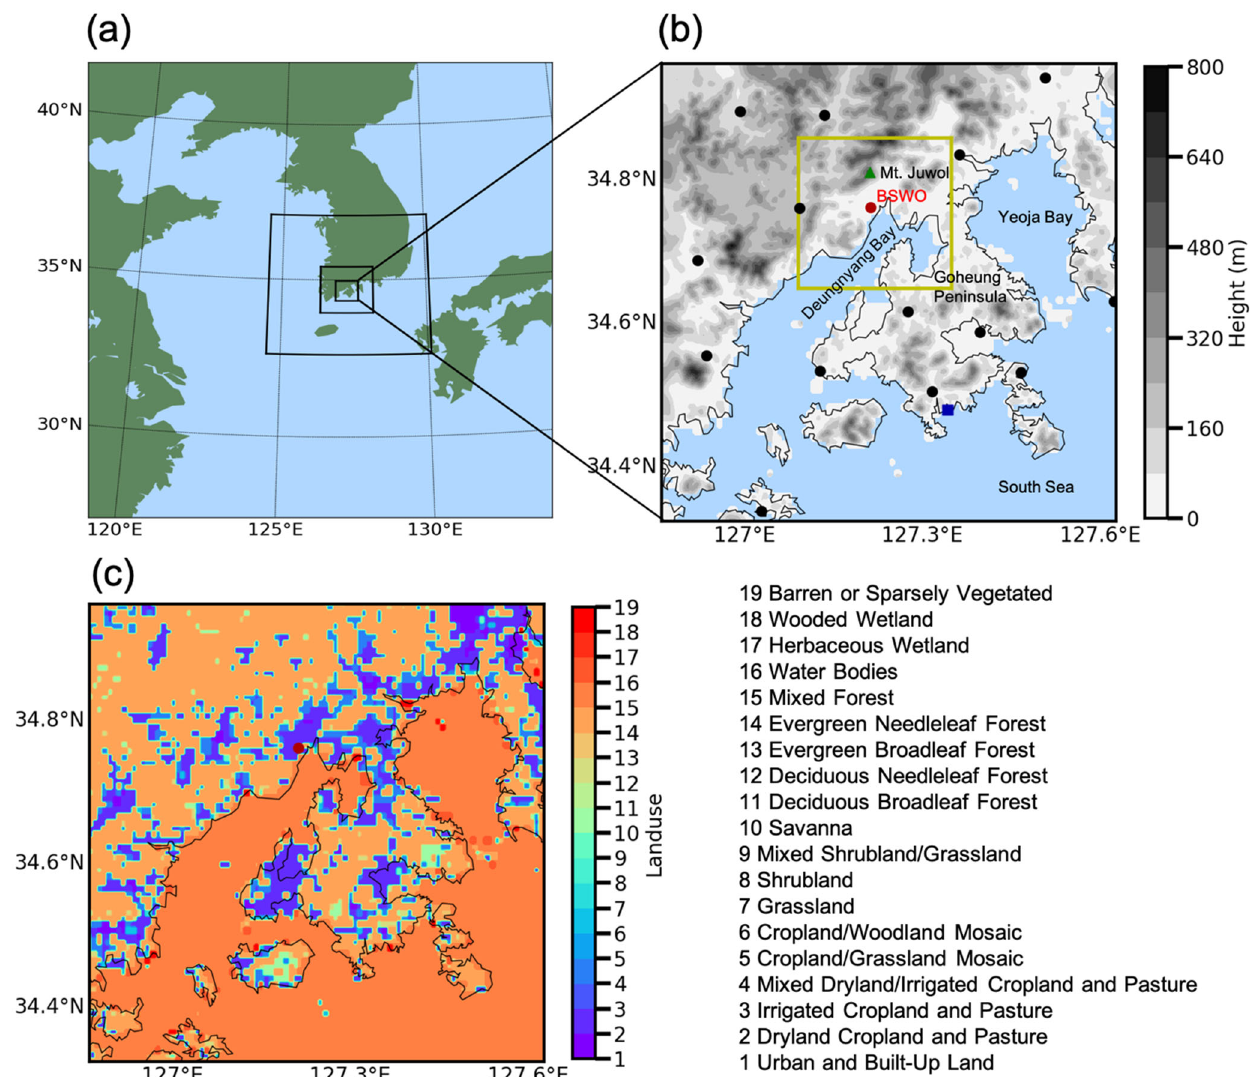
Figure 1. ( a ) Four domains (D01, D02, D03, and D04) used in the WRF model, ( b ) terrain height in D04, and ( c ) land use in D04. The locations of the BSWO and Goheung-Balpo station are denoted by a red dot and a blue square, respectively, in ( b ). The black dots in ( b ) indicate the locations of AWS/ASOS observation. The box inside ( b ) is the analysis domain zoomed in for D04.